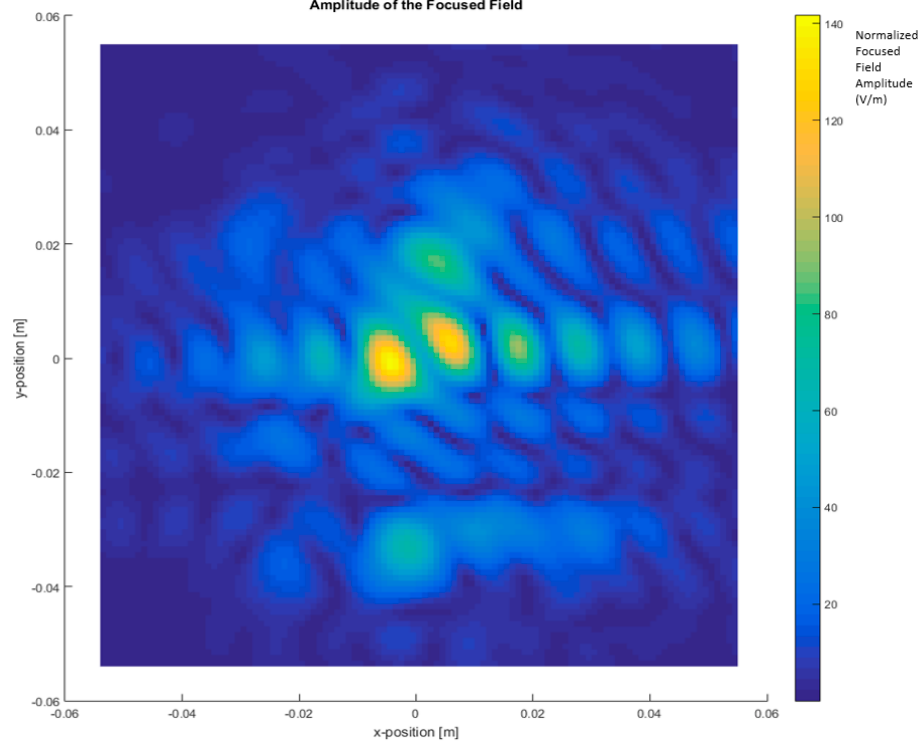
Figure 11. Differential focused field amplitude between the metallic car with and without an antenna. Frequency range: 295 GHz to 305 GHz (BW = 10 GHz) [2].